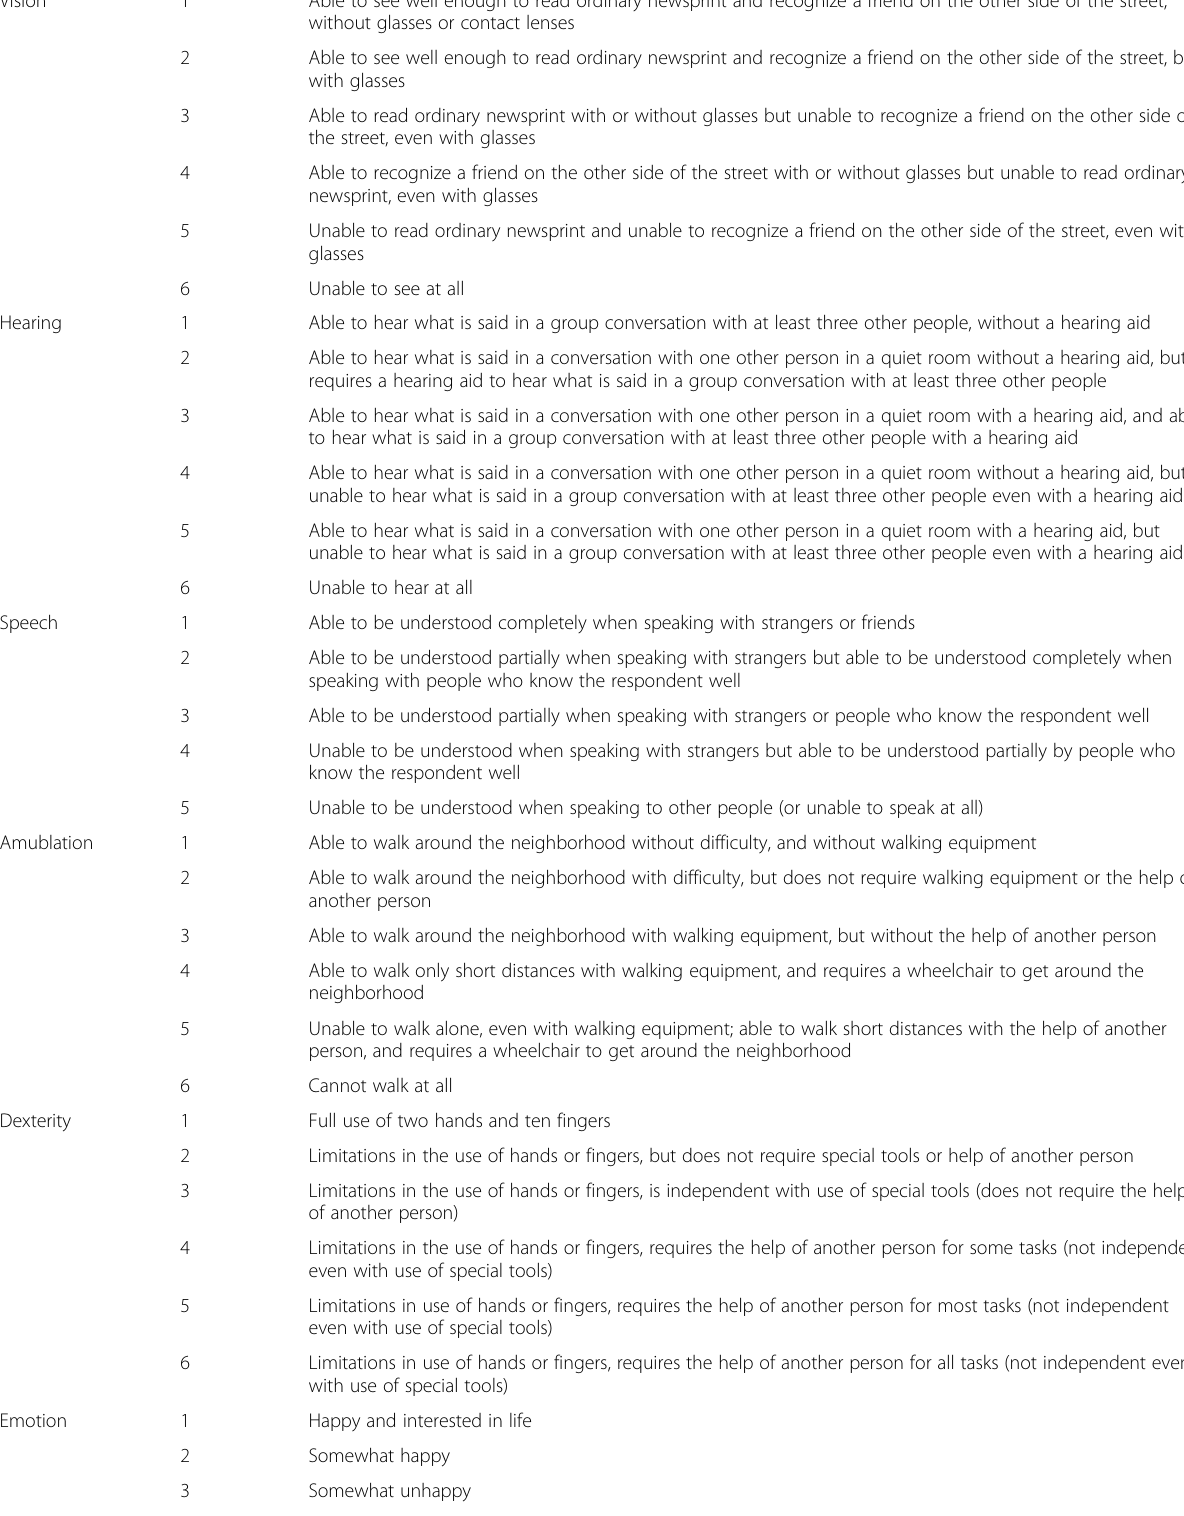
Table 1 HUI Mark III health status classification